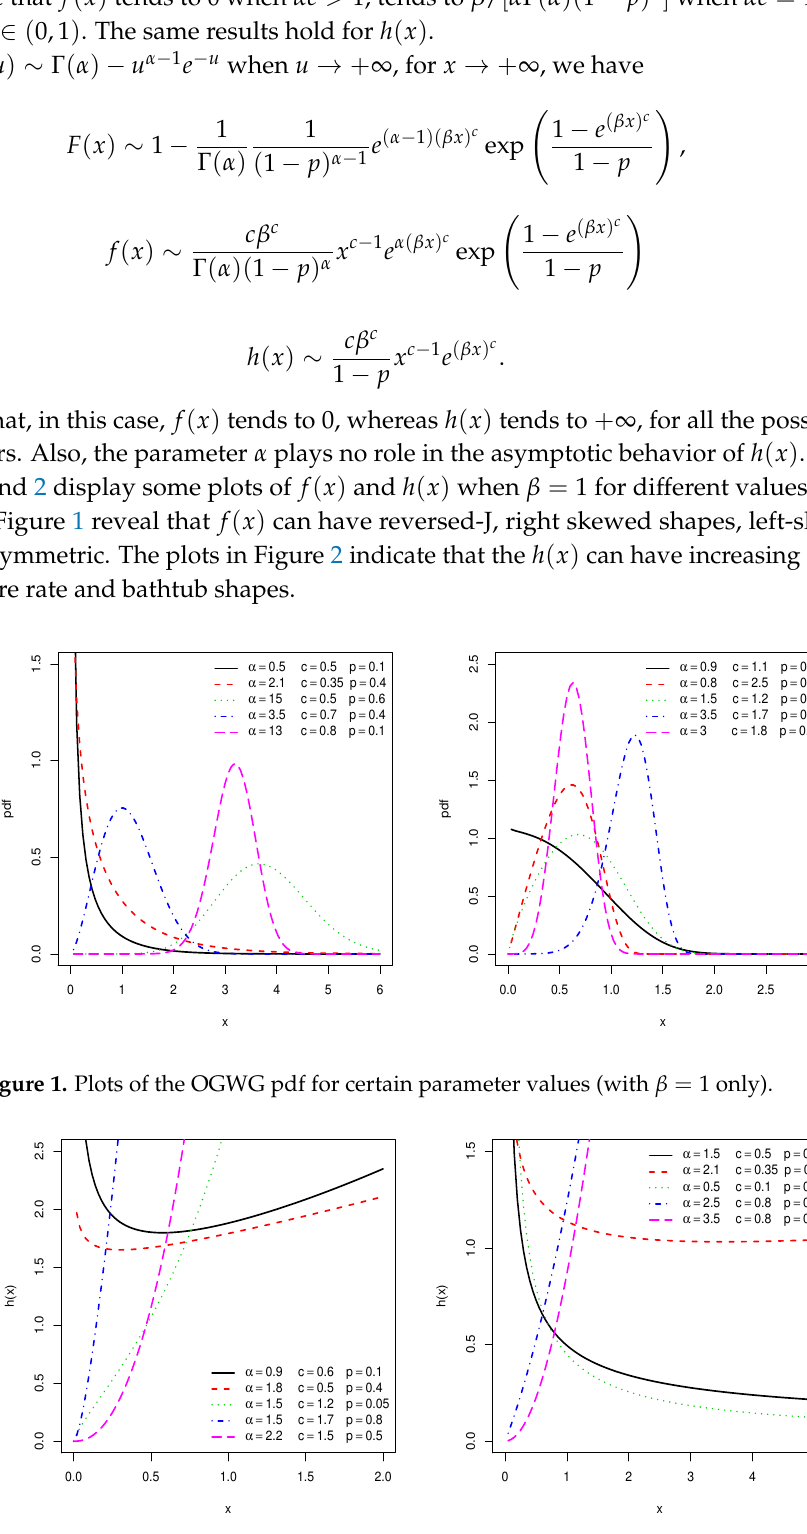
Figure 2. Plots of the OGWG hrf for certain parameter values (with β = 1